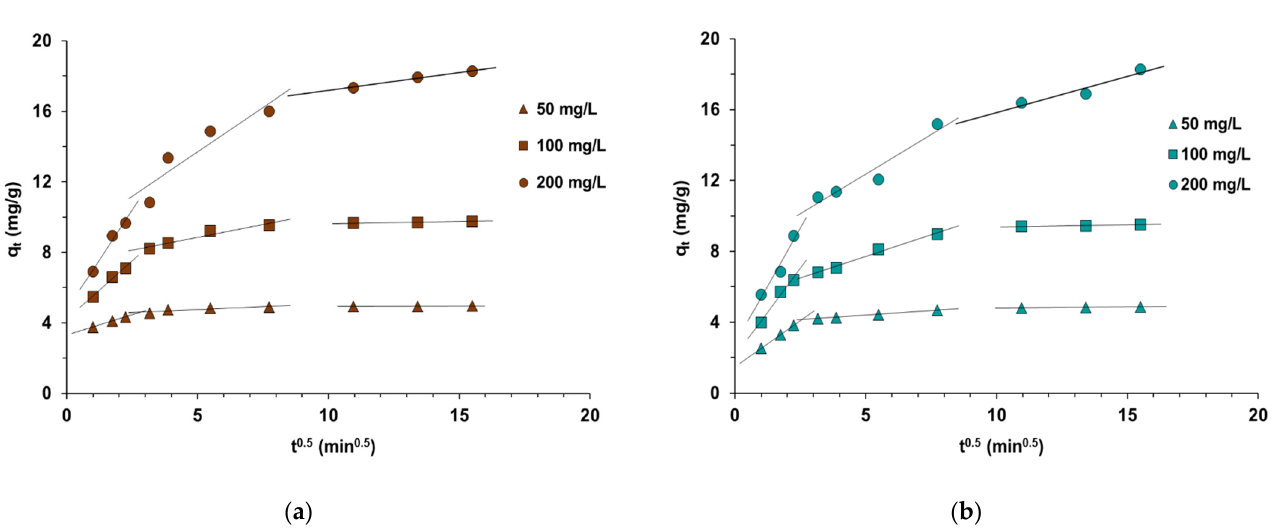
Figure 4. Intraparticle diffusion kinetic model for BB3 adsorption on ( a ) sawdust and ( b ) Cladium mariscus.